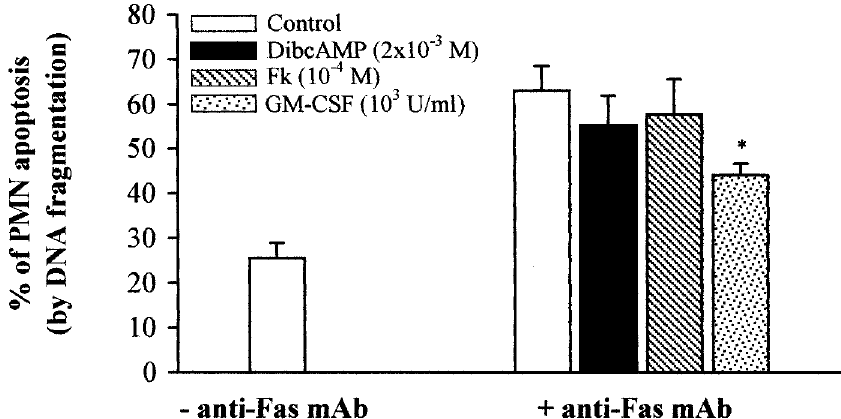
FIG. 2. Differential effects of GM-CSF and cAMP-elevating agents on Fas-induced neutrophil apoptosis. PMN were pretreated with or without GM-CSF (1000UI/ml), dibutyryl cAMP (2 3 10 –3 M) or forskolin (10 –4 M) for 2h, and then supplemented withmAb CH-11 (150ng/ml) or medium alone for a further 12h of incubation, before DNA extraction and analysis. Results represent the ratio of DNA cleavage products to high molecular weight DNA expressed as percentage (mean±SD), in 15 healthy volunteers. Significance versus control: * p <0.001.